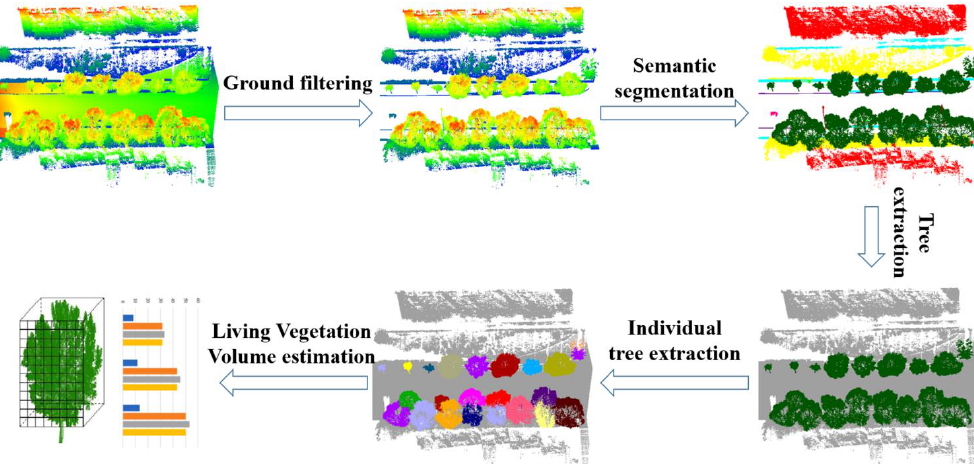
Figure 1. Pipeline of the proposed framework. The tree extraction stage divides the input point cloud into tree and non-tree points. The individual tree separation module takes the tree points as input data and obtains the individual road-side trees.